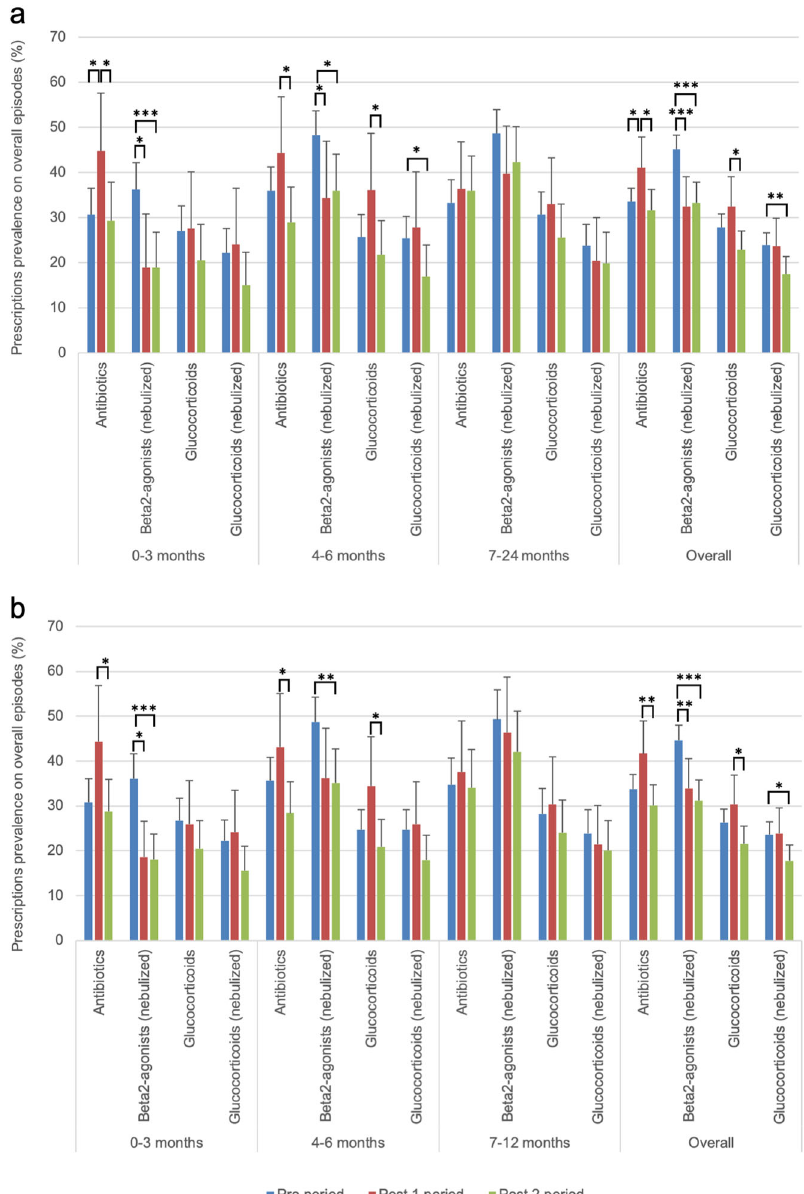
Fig. 2 Prevalence of treatments in the different periods and age groups (Pedianet, 2012-2018). Treatments for bronchiolitis episodes in the different periods described by age group in the overall cohort ( a ) and in children < 1 year of age having a fi rst episode of bronchiolitis ( b ). Positive error bars indicate the higher con fi dence interval limit (97.5%) for the percentages. Signi fi cant χ 2 test p values are reported as asterisk (*), if 0.05 ≥ p value > 0.01 then *, if 0.01 ≥ p value > 0.001 then **, and if p value ≥ 0.001 then